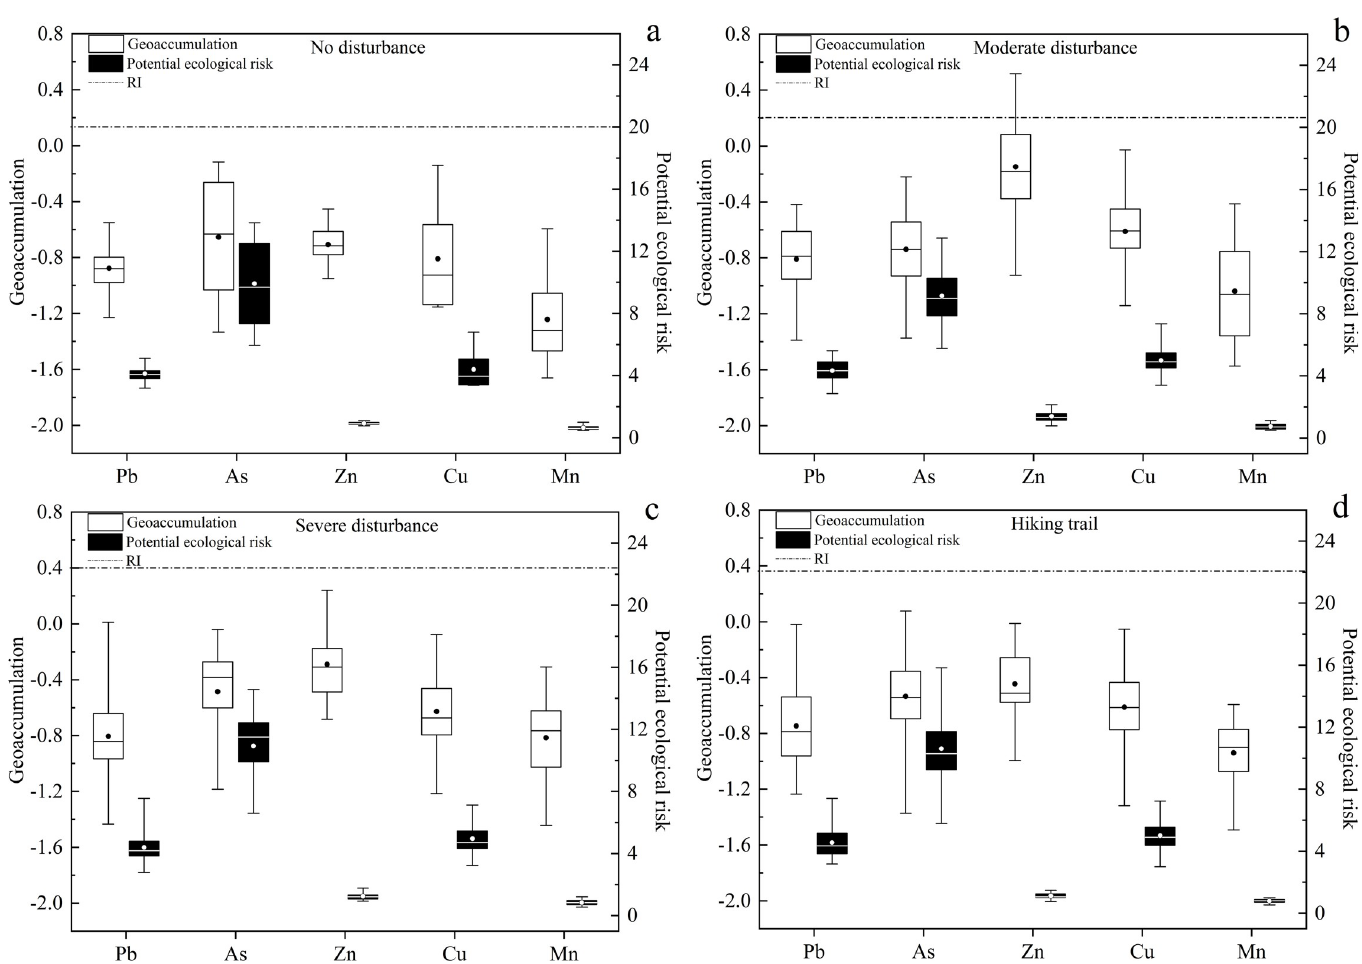
Fig 6. Geoaccumulation and potential ecological risk of heavy metal in Juhuatai Scenic